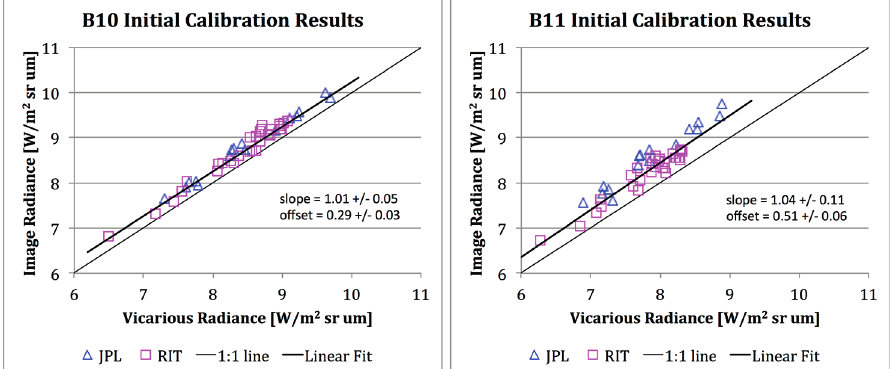
Figure 9. The initial vicarious calibration results for both TIRS bands, based on the day JPL and RIT buoy data. If the instrument were perfectly calibrated, the data would fall scattered about the 1:1 line. All results for both bands are above the 1:1 line indicating that the instrument is predicting too